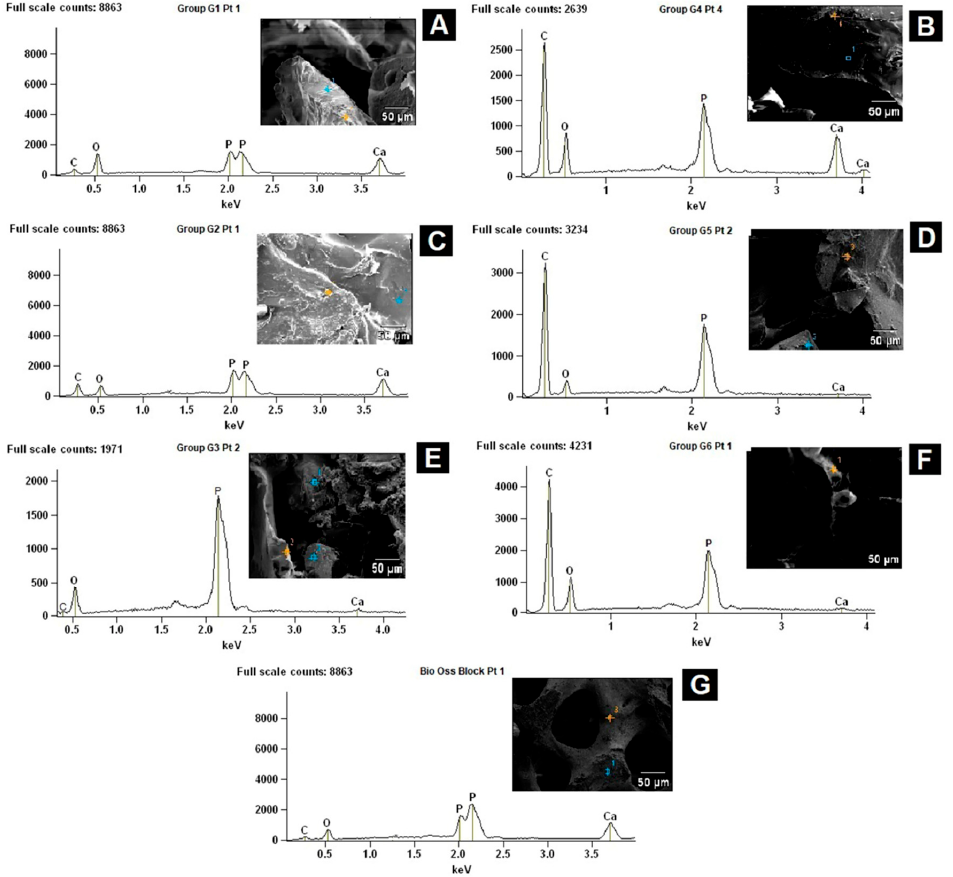
Figure 3. Chemical analysis by an energy-dispersive spectrometer (EDS) of all composite groups made of polylactic-co-glycolic acid (PLGA) and biphasic ceramic (HA + β -TCP) at different ratios: G1, 50 / 50 + collagen ( A ); G2, 60 / 40 + collagen ( C ); G3, 40 / 60 + collagen ( E ); G4, 50 / 50 ( B ); G5, 60 / 40 ( D ); G6, 40 / 60 ( F ); and control group ( G ), which revealed the presence of carbon (C), oxygen (O), calcium (Ca), and phosphorus